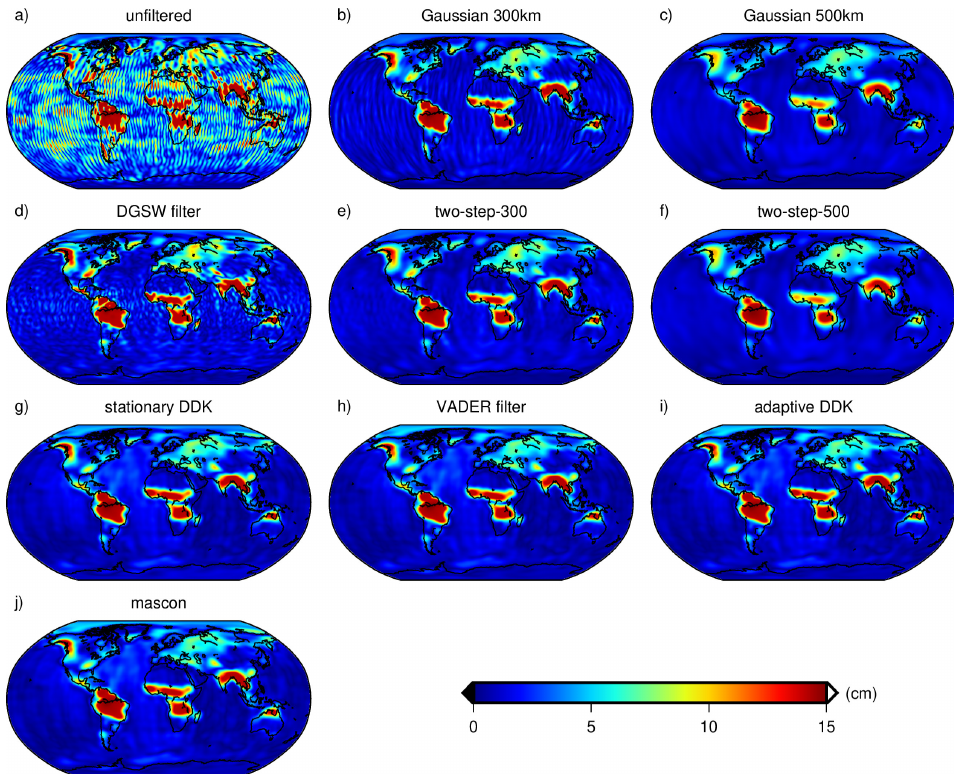
Figure 12. Annual amplitude of different filtered solutions in terms of EWH from January 2004 to December 2010. The annual amplitude is derived from annual periodic terms.